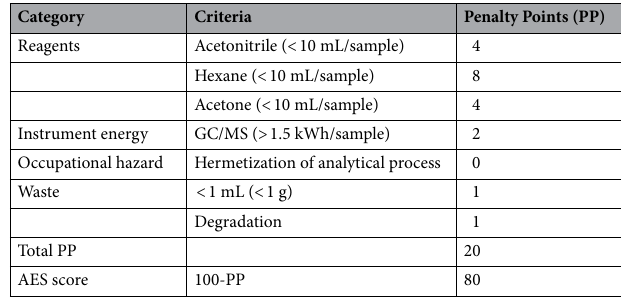
Table 5. Analytical EcoScale score points of the developed analytical